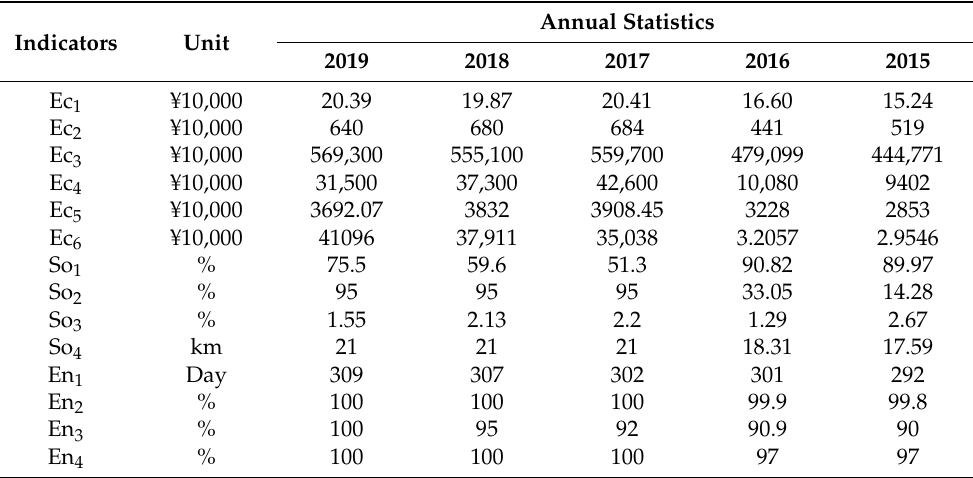
Table 8. Statistics of assessment indicators for sustainability contribution in Jiansheng town from 2015 to 2019.